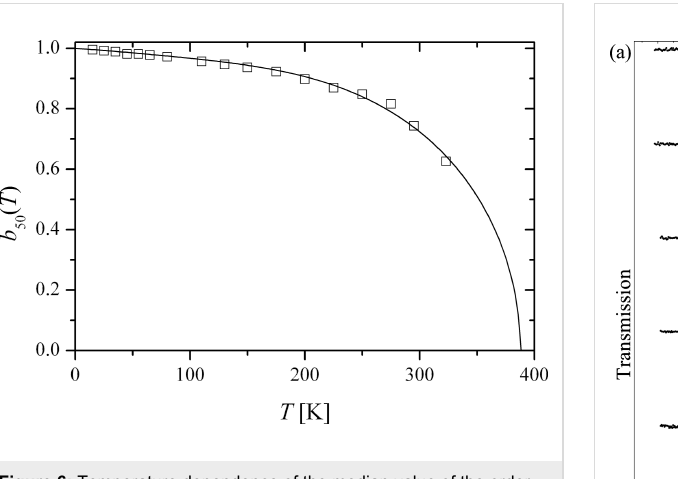
Figure 6: Temperature dependence of the median value of the order parameter, b 50 ( T ) for interacting 20 nm hematite nanoparticles. The open squares are the experimental data, and the solid line is a fit to the superferromagnetism model (Equation 11). Adapted from Hansen, M. F. ; Koch, C. B.; Mørup, S. Magnetic dynamics of weakly and strongly interacting hematite nanoparticles, Phys. Rev. B 2000, 62, 1124. Copyright (2000) by the American Physical Society.